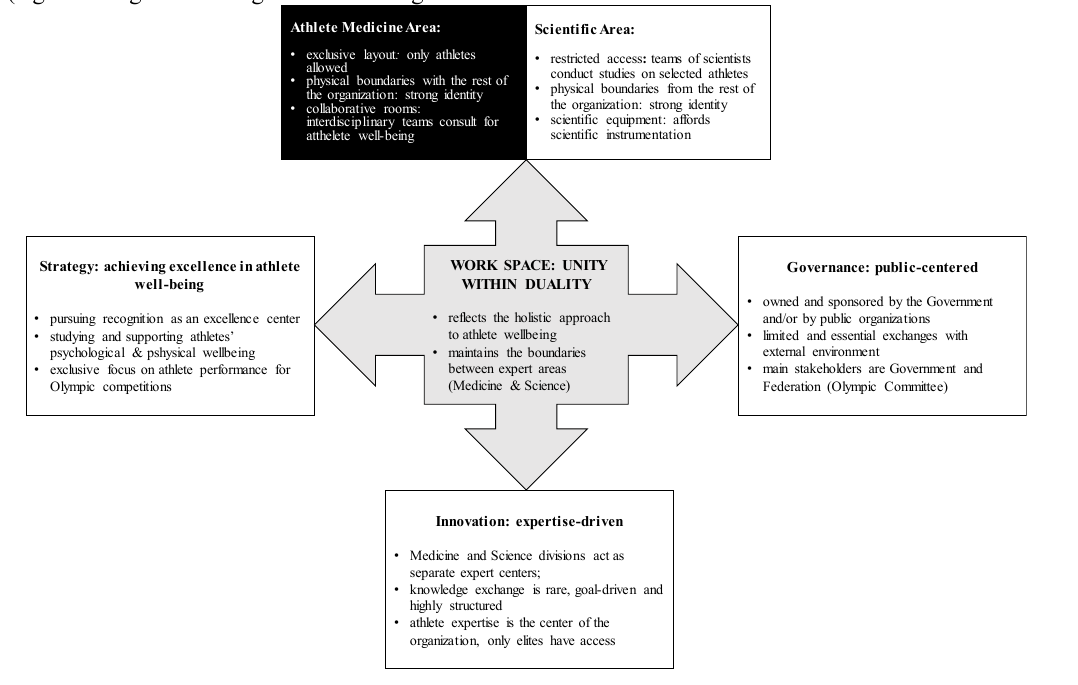
Fig. 1. Pre-experimental condition: Dominance of logic 1: dualistic space, holistic expert